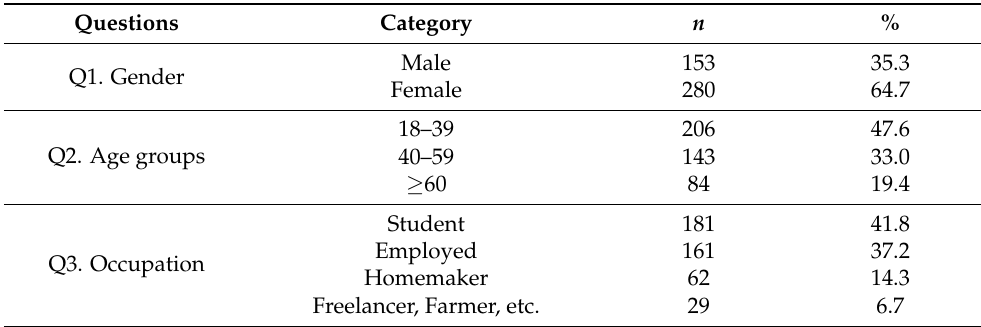
Table 1. Descriptive statistics of survey respondents ( n =